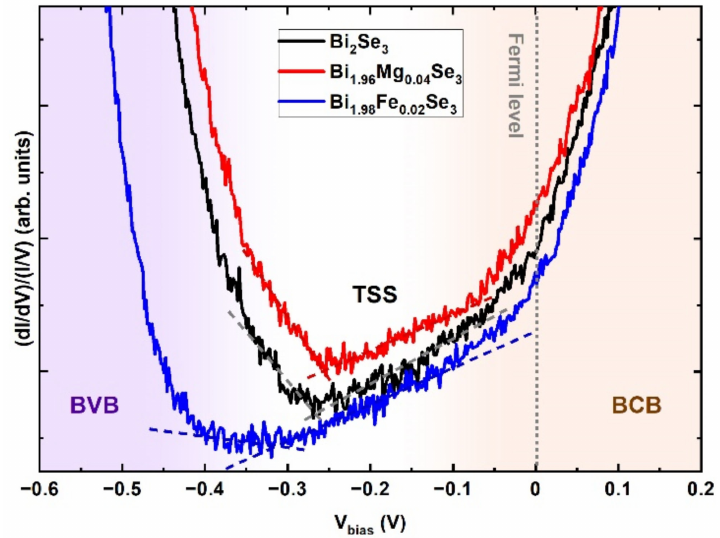
Figure 4. Normalized STS spectra measured at room temperature at positions between the defects, i.e., on structurally perfect areas of the Bi 2 Se 3 , Bi 1.96 Mg 0.04 Se 3 and Bi 1.98 Fe 0.02 Se 3 surfaces. The regions of the BVB, BCB and TSS are marked with the violet, orange and white background, respectively. The segments with a linear dispersion relation are marked with